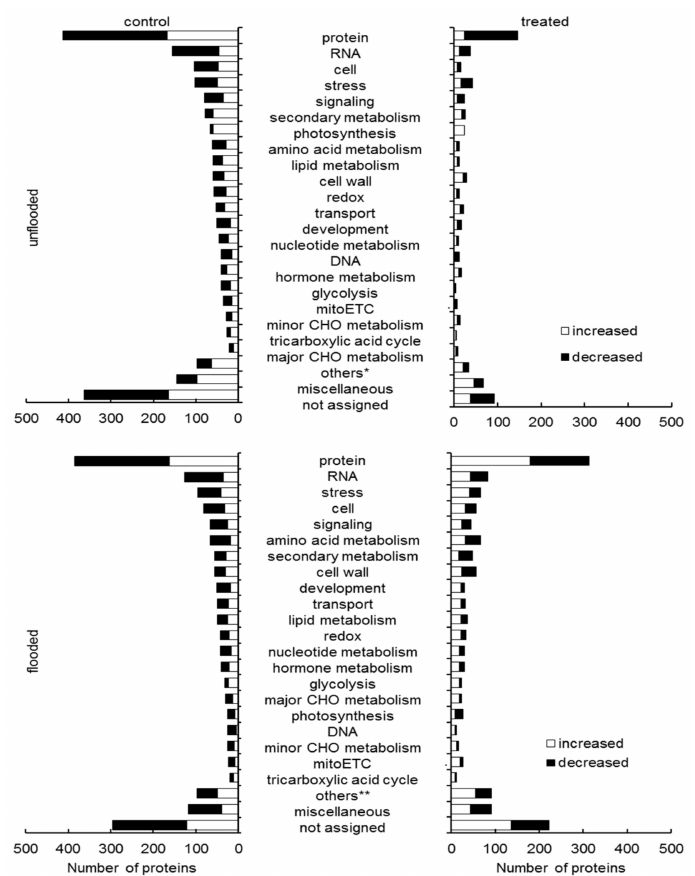
Figure 2. Functional categories of proteins in root-hypocotyl tissue with di ff erential abundance in soybean treated with millimeter-waves irradiation and flooding. Soybean seeds irradiated with millimeter waves were sowed and treated, which is indicated in materials and method.